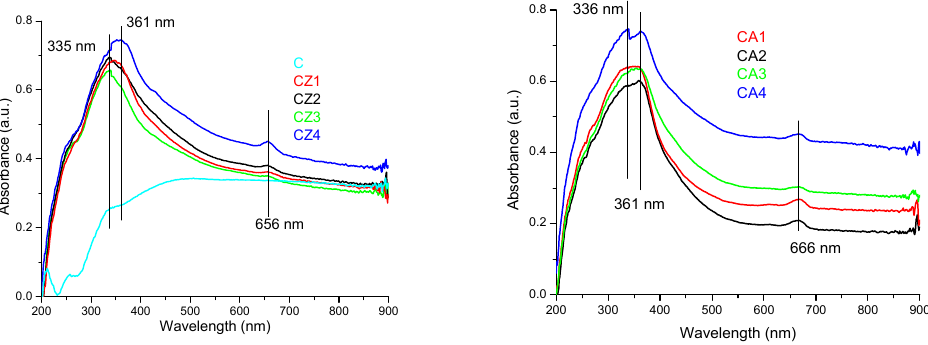
Figure 4. The UV-Vis spectra for chitosan and CZ1–CZ4 films ( left ) and CA1–CA4 films ( right ).